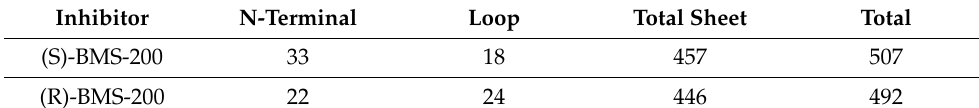
Table 2. Contact numbers in the binding domains of the S and R systems.